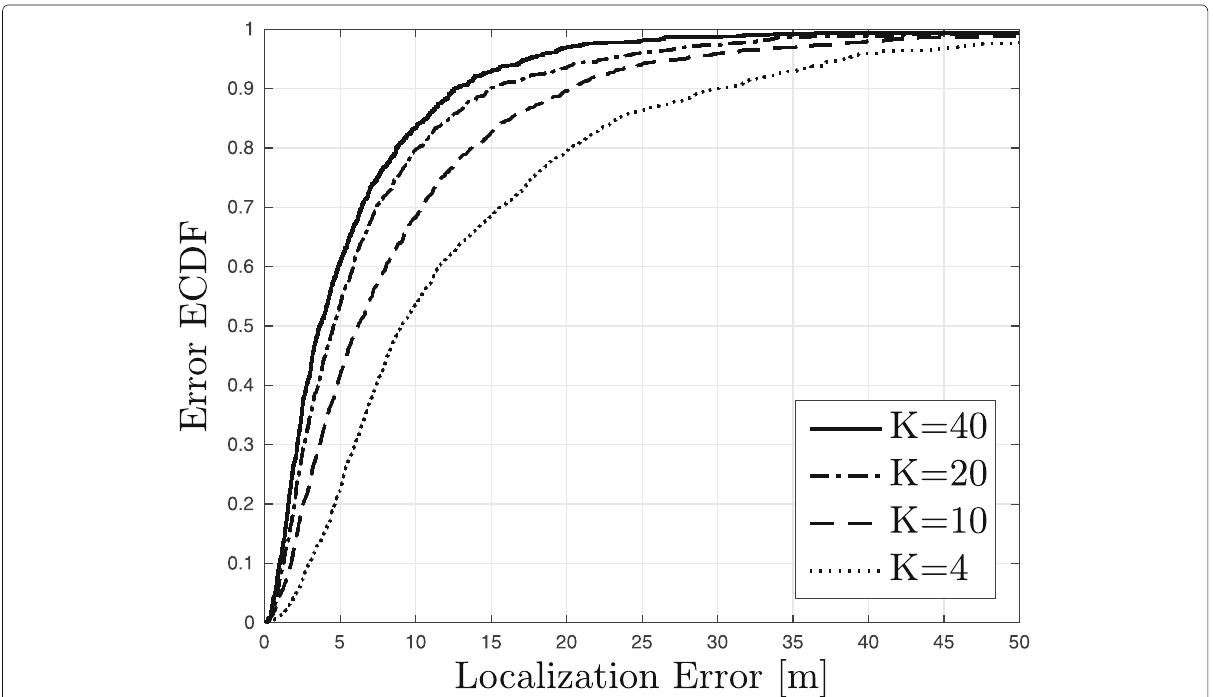
Fig. 10 Error ECDFs of RDML for various values of K in fully connected networks with white Gaussian noise and randomized NLoS fraction, N a = 11, N u =